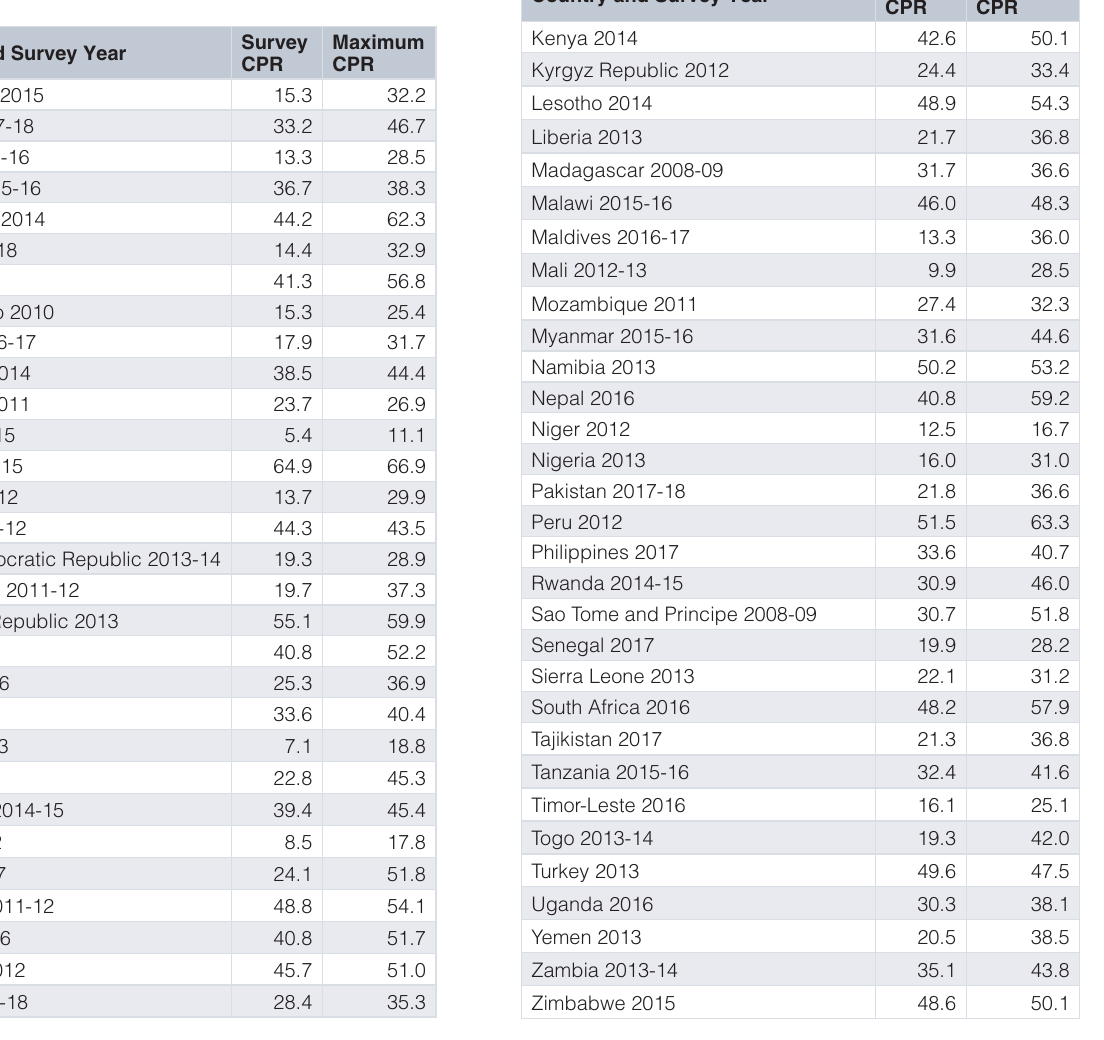
Table 3. Maximum CPR with Default Data and Survey